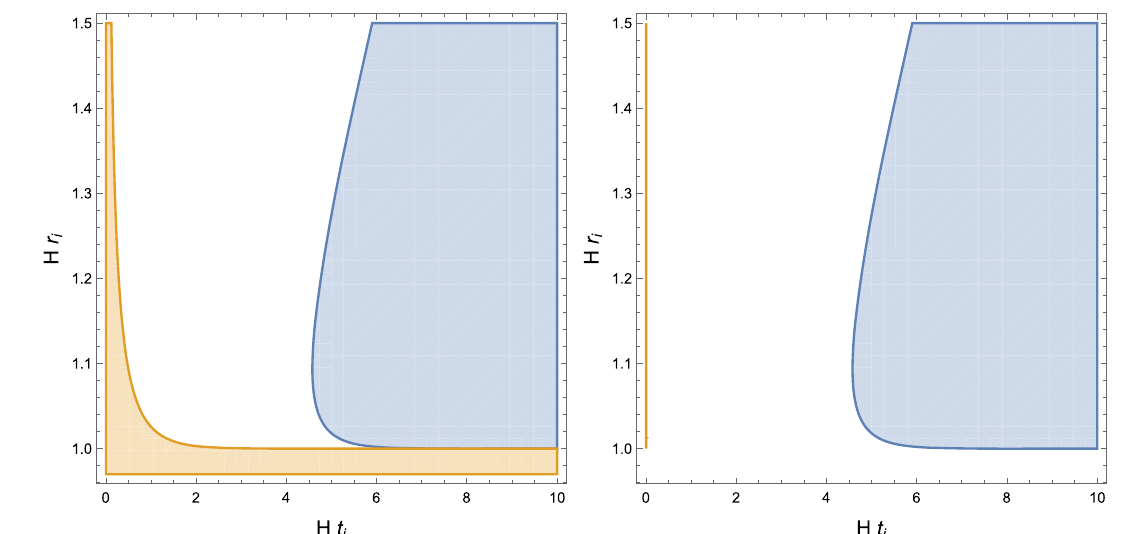
whole region Hr i > 1. (Right): Evolving central charge case with ( dc / dr )/( cH ) = 0 . 5 [ ( Hr )/( H 2 r 2 − 1 ) ] . While condition 1 is i i i ( I ) ≤ unchanged and ∂ U S gen ( I ) ≥ 0 in condition 2 still holds in whole region V S gen Hr i > 1, the region satisfying ∂ V S gen ( I ) ≤ 0 in condition 2 shrinks. Moreover, ∂ U S gen ( G ) ≤ 0 in condition 3 is not satisfied in any region